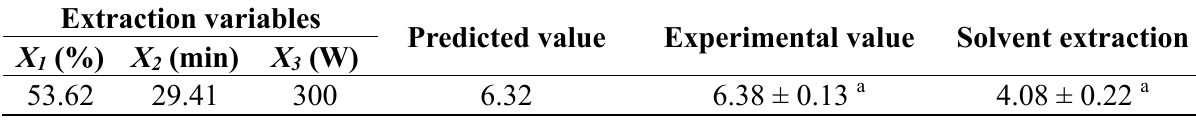
Table 3. Predicted and experimental values of total flavonoids obtained under the optimal extraction conditions and solvent extraction